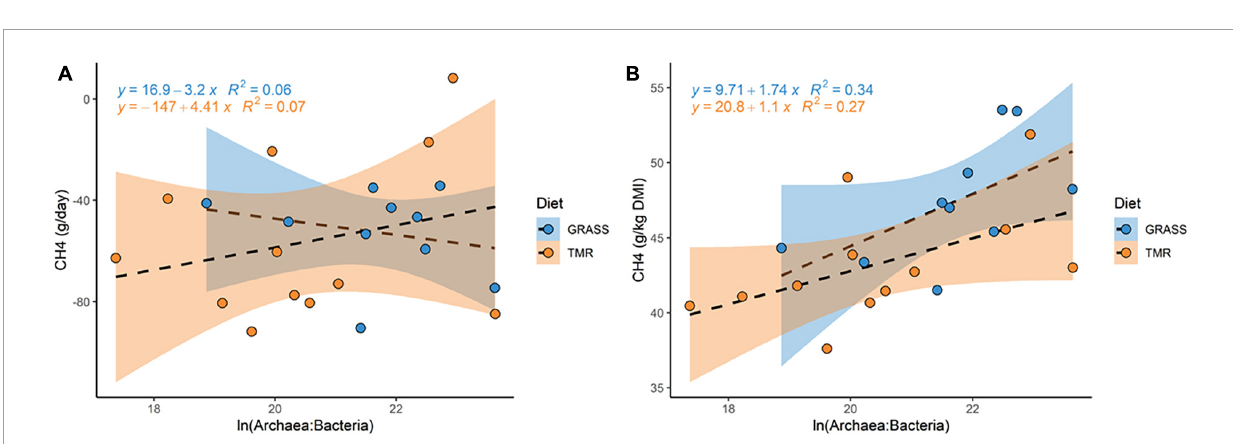
FIGURE2 Data distribution of methane emissions [expressed as (A) methane production (g/day) or (B) methane yield (g/kg DMI)] and the natural log-ratio between archaea and bacteria abundances within animals offered two contrasting diets, high concentrate (TMR) or fresh cut grass (Grass). Methane and natural log-ratio between archaea and bacteria abundances was pre-corrected by fixed effects of breed, and body weight as a